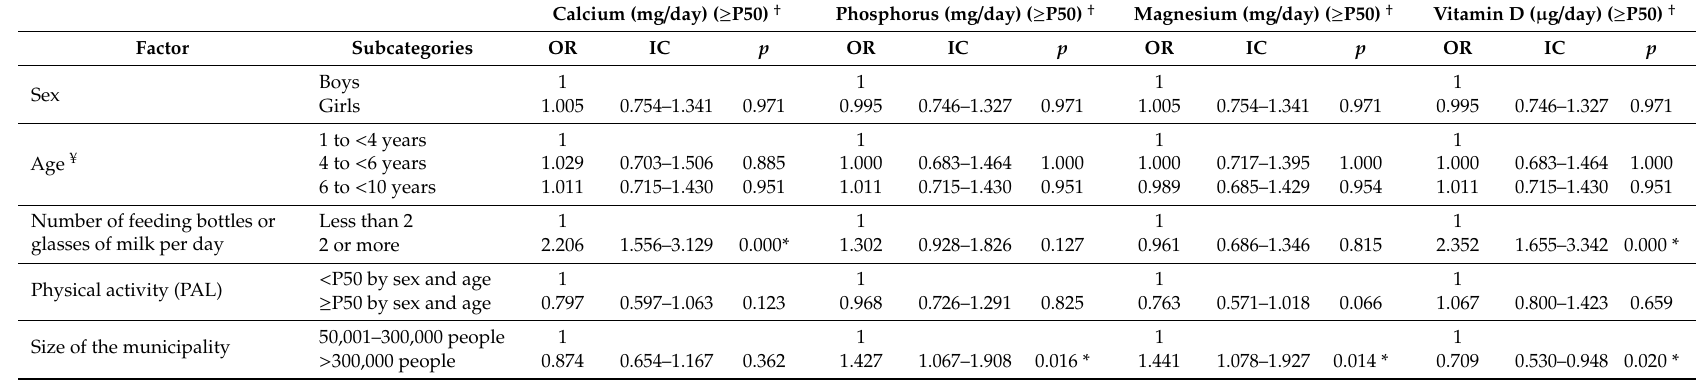
Table 4. Odds ratios and 95% confidence intervals for the presence of an intake similar to or greater than the median of calcium, phosphorus, magnesium, and vitamin D, relative to family and personal factors, in the adapted milk consumer sample (AMS) of the EsNuPI children population (n =